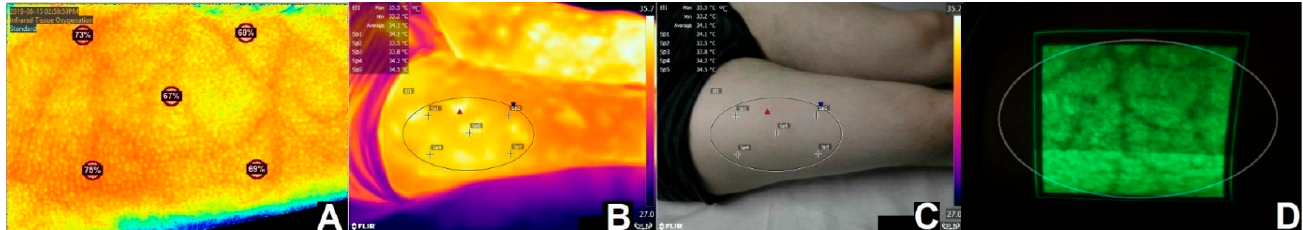
Figure 9. Comparison of the images captured by all devices used in the study at t0; elliptic areas represent the location of topical negative pressure (TNP). ( A ) Image captured by near-infrared spec- troscopy. ( B , C ) Images captured by thermography, in representative color spectrum and original image. ( D ) Live image created by vein illuminator, captured with digital camera. The white elliptic area represents the location of